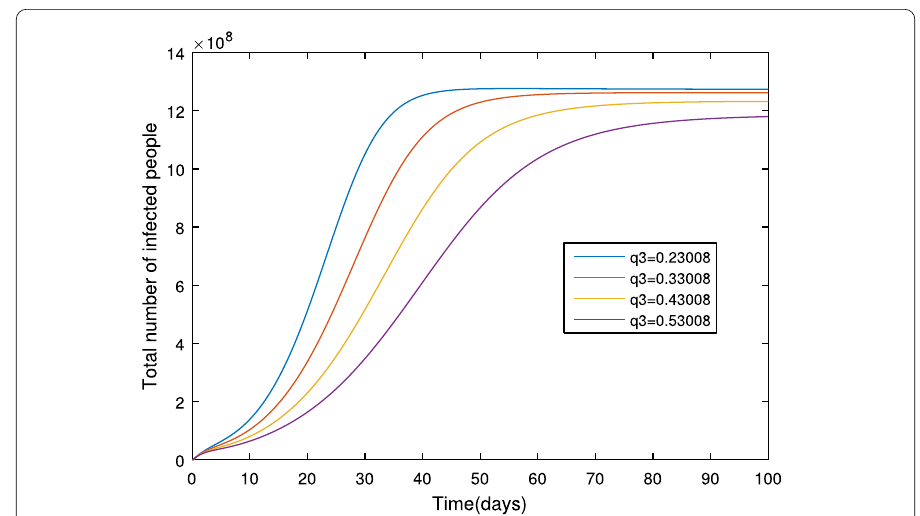
Figure 8 The total number of infected people for different values of q 3